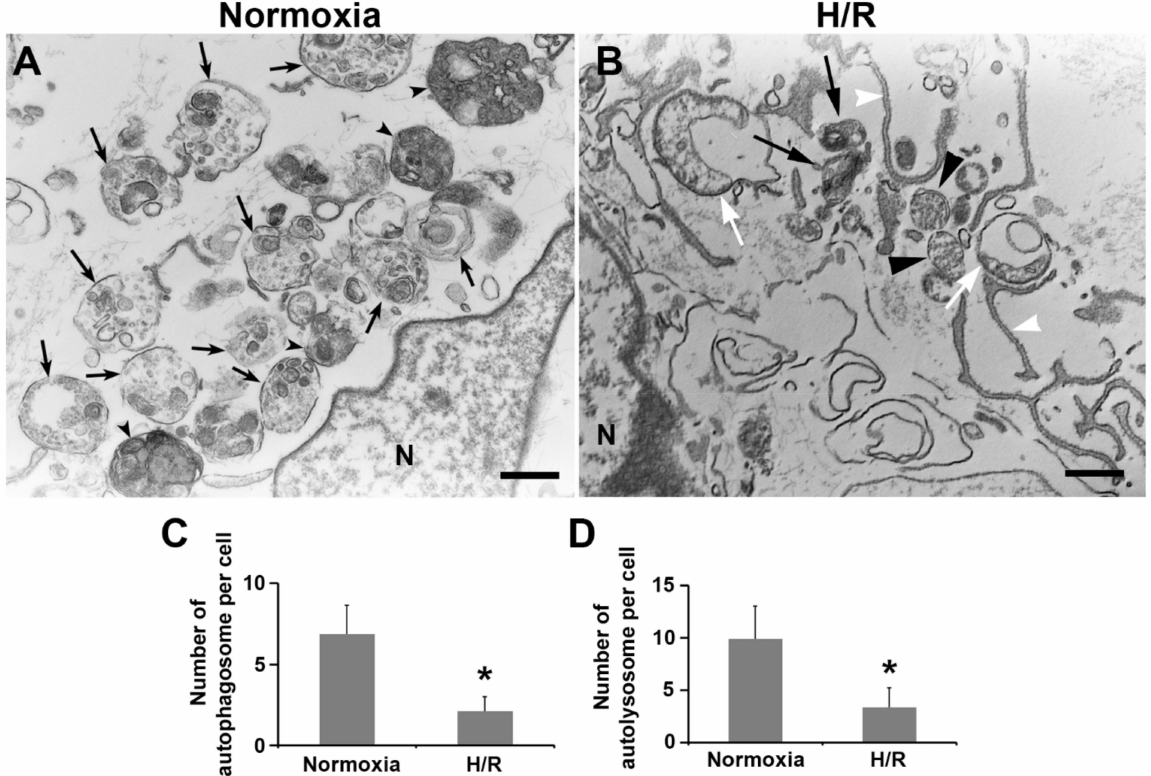
Figure 5. Ultrastructural analysis of autophagic vacuoles in normoxia- and H/R-treated PHTs. ( A ) Representative electron micrograph showing autophagic vesicles in a normoxia-treated cell. Black arrows indicate autophagosomes, while arrowheads show autolysosomes. ( B ) Representative electron micrograph showing autophagic vacuoles in an H/R-exposed cell. White arrows point to damaged mitochondria. White arrowheads indicate isolation membranes. Black arrows and arrowheads show autolysosomes and autophagosomes, respectively. N: the nucleus. Bar: 600 nm. ( C , D ) Statistical comparison of the number of autophagosomes and autolysosomes between normoxia- and H/R-treated cells. Data are expressed as mean ± SEM and statistically analyzed by a Student’s t -test ( n = 30, *: p <